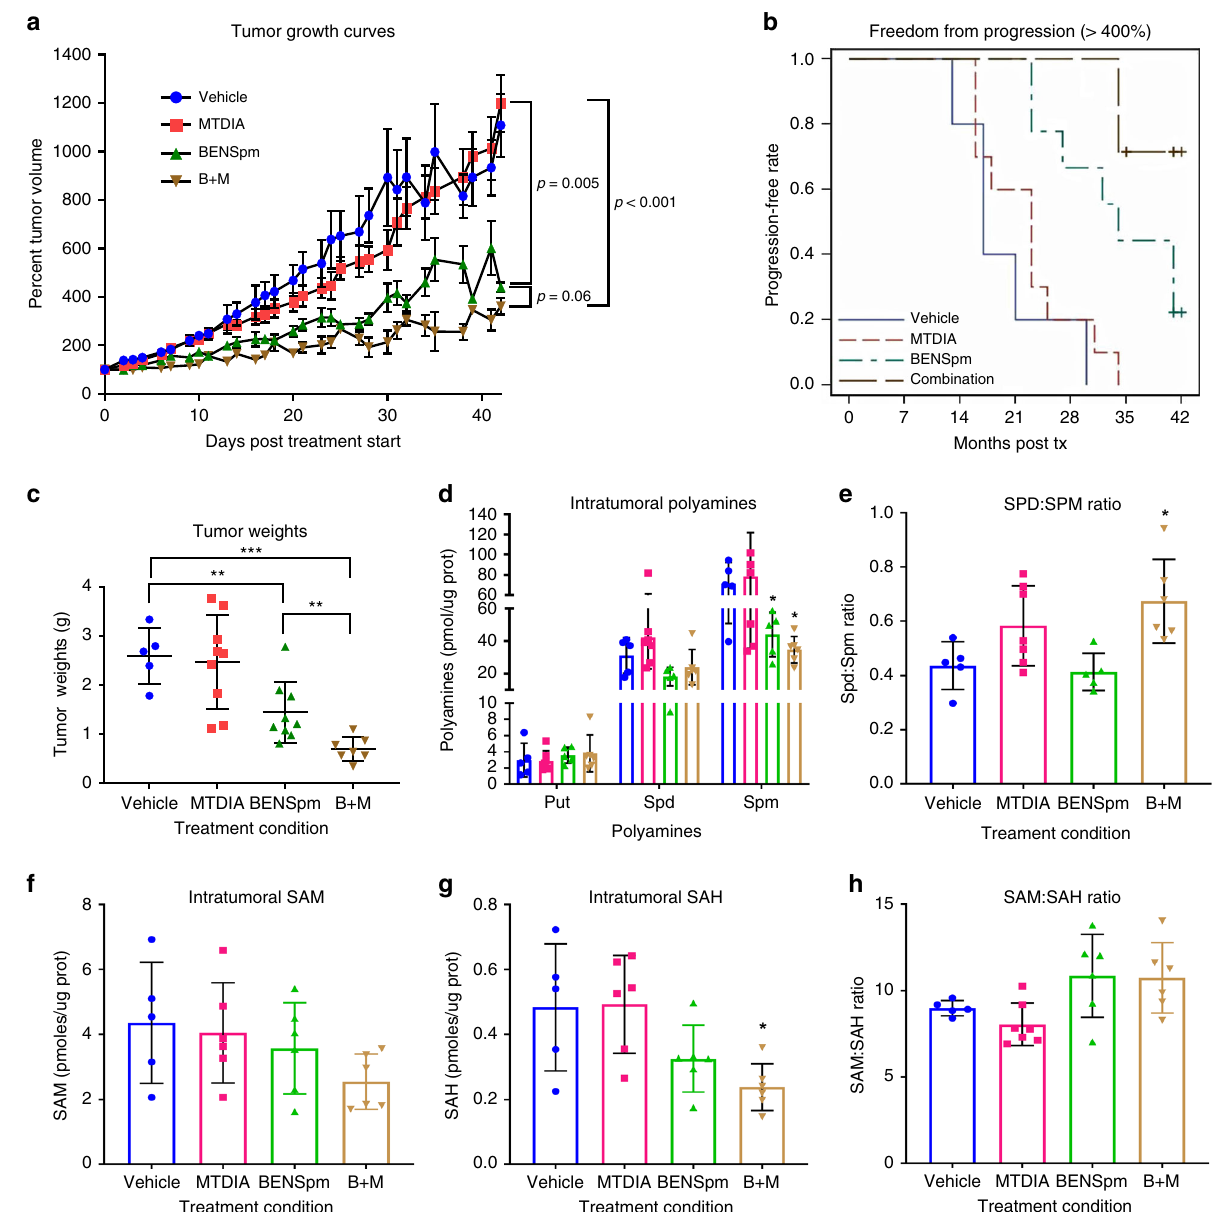
Fig. 5 BENSpm and MTDIA in combination provide the greatest ef fi cacy in vivo. Animals were subcutaneously implanted with 1 × 10 6 CWR22Rv1 cells. Once tumors reached between 300 and 400mm 3 animals were placed on one of the four treatment cohorts, vehicle (blue), 50 mg/kg MTDIA (red), 100 mg/kg BENSpm (green) or the combination of 50 mg/kg MTDIA and 100 mg/kg BENSpm (brown). a Mean tumor sizes over time are plotted for each animal of the four treatment groups made relative to the starting tumor size at treatment day 0. The log relative tumor volume was modeled as a function of treatment, time, the time-treatment interaction, and random mouse effects and slopes using a linear mixed model. The growth rates were compared using tests about the appropriate linear contrasts of model estimates. (Vehicle; n = 5, MTDIA; n = 11, BENSpm; n = 9, Combo; n = 8). b The graph indicates progression free survival where progression is de fi ned as reaching 400%. c The tumor weights at sacri fi ce for each group. (Vehicle; n = 5, MTDIA; n = 9, BENSpm; n = 9, Combo; n = 7). d Intratumoral polyamines (putrescine, spermidine, and spermine), e the spermidine-to-spermine ratio, f Intratumoral SAM levels, g Intratumoral SAH levels, and h the SAM:SAH ratio as measured by UPLC normalized to protein concentrations. (where for D-H Vehicle; n = 7, MTDIA; n = 9, BENSpm; n = 9, Combo; n = 7). Statistical analyses for graphs C-H were performed using an unpaired Student ’ s t -test with Welch ’ s correction. All values are compared to vehicle control unless otherwise indicated by connecting lines. Error bars represent standard deviation of the mean. * p < 0.05, ** p < 0.01, *** p <